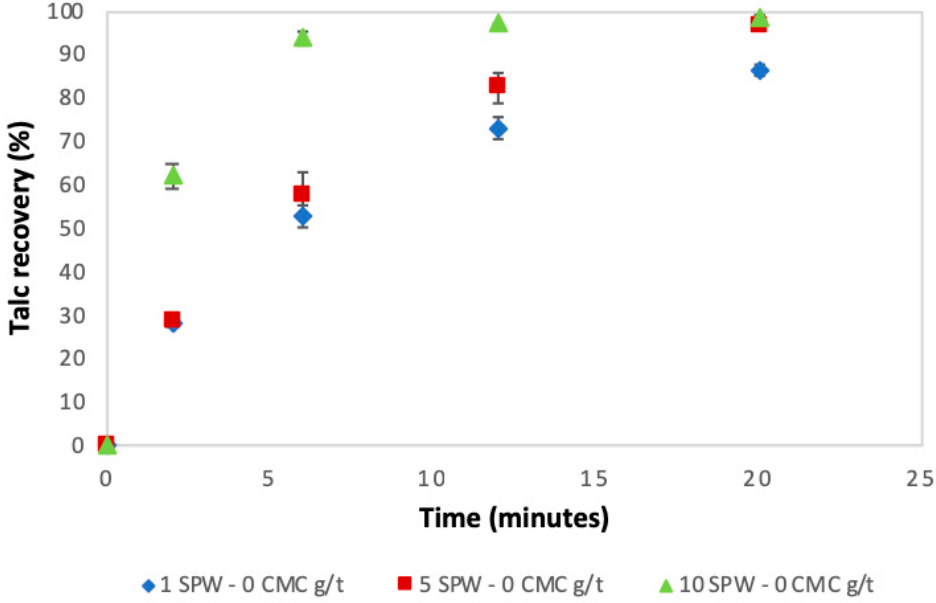
Figure 2. Total talc recoveries in increasing ionic strength without (0 CMC g / t) and with carboxymethyl cellulose (CMC) (300 CMC g / t).